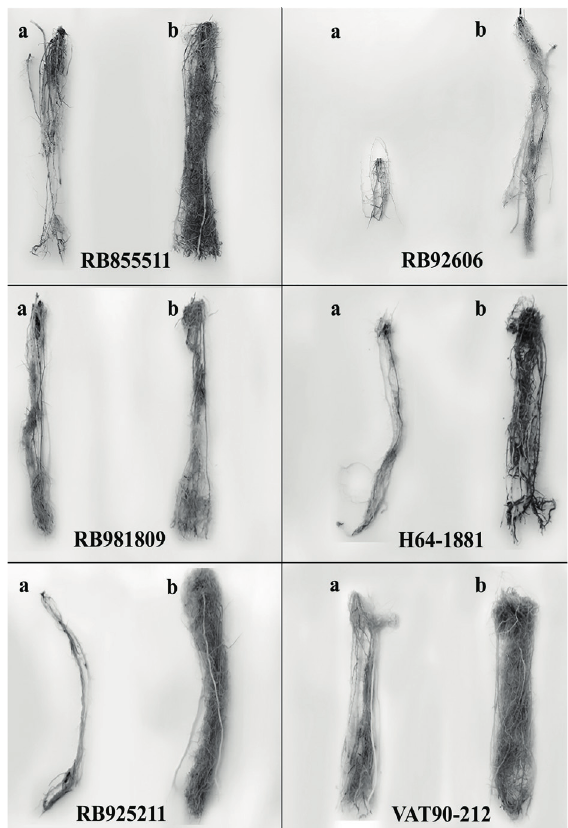
Figure 1 - Digital images of sugarcane seedling roots from different hybridizations among RB92579 (as pollen recipient – a and pollen donor – b ) and other six sugarcane